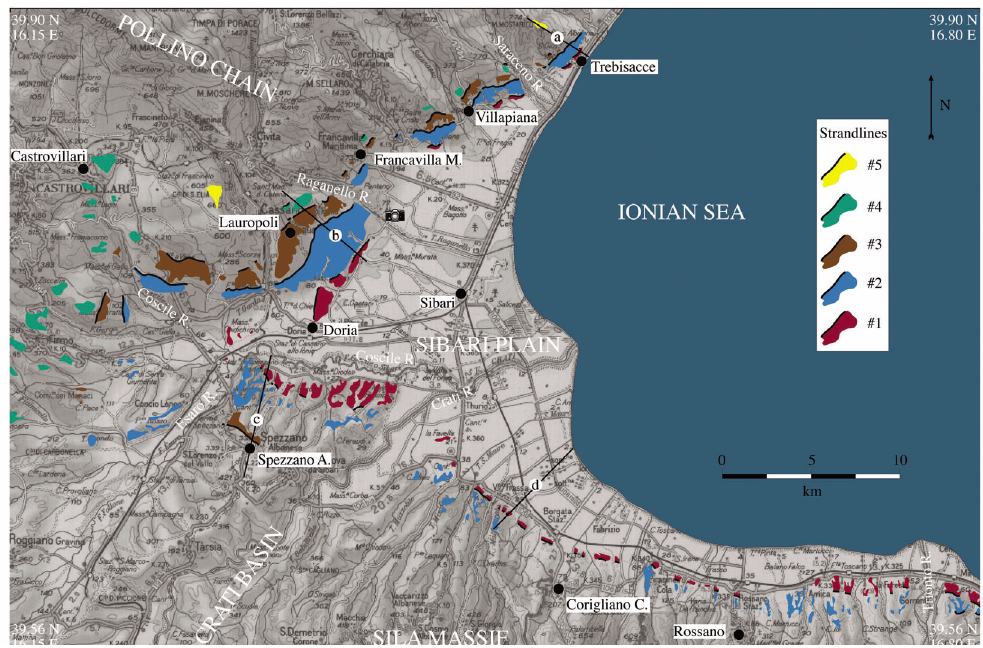
Fig. 2. Map of the five marine terraces (#1 to #5, lowest to highest) that contour the Sibari Plain; different colours are associated with the wavecut platforms and black thick lines mark the inner edges. Black segments marked by letters ‘a’ to ‘d’ indicate the traces of the four longitudinal profiles in fig. 5a-d. A camera marks the site location of the photo in fig. 4. The contour interval of the map is 100